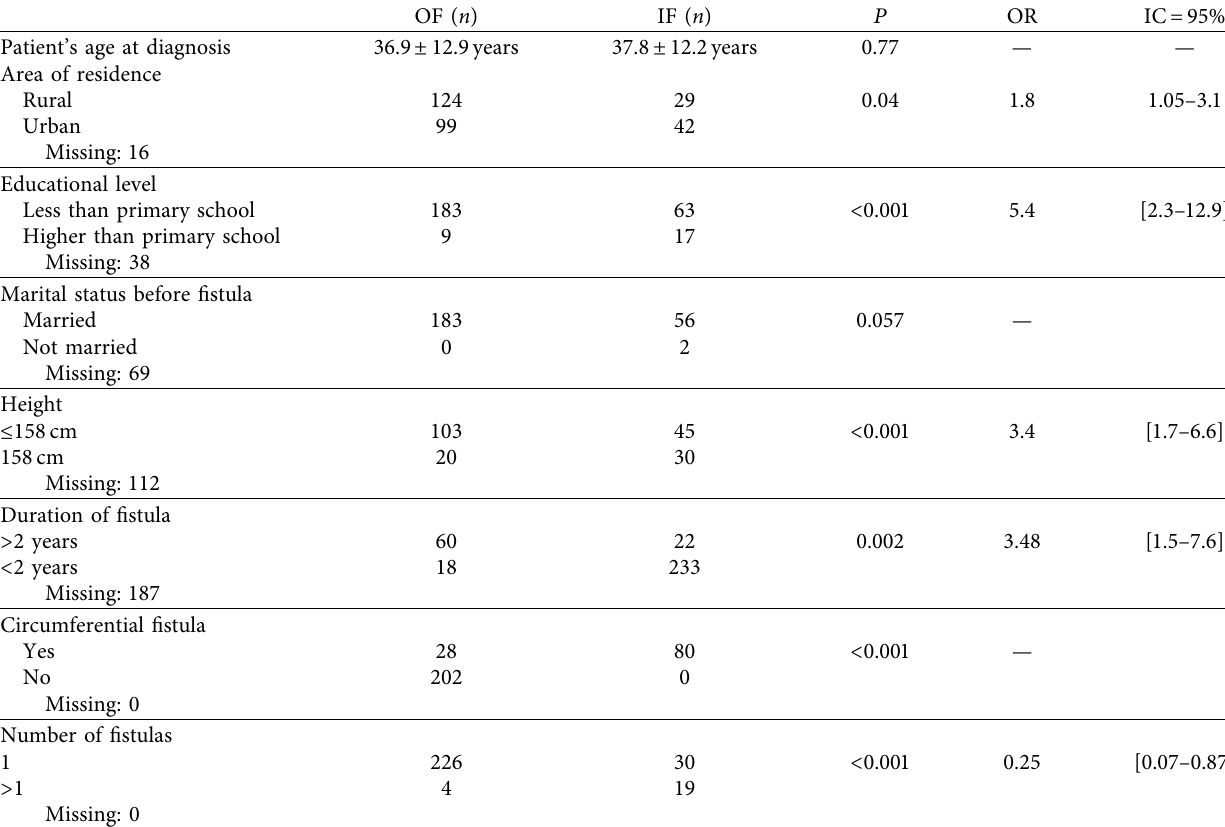
Figure 1: Flowchart of how we selected subjects for our Table 1: Sociodemographic, clinical, and therapeutic characteristics of patients.